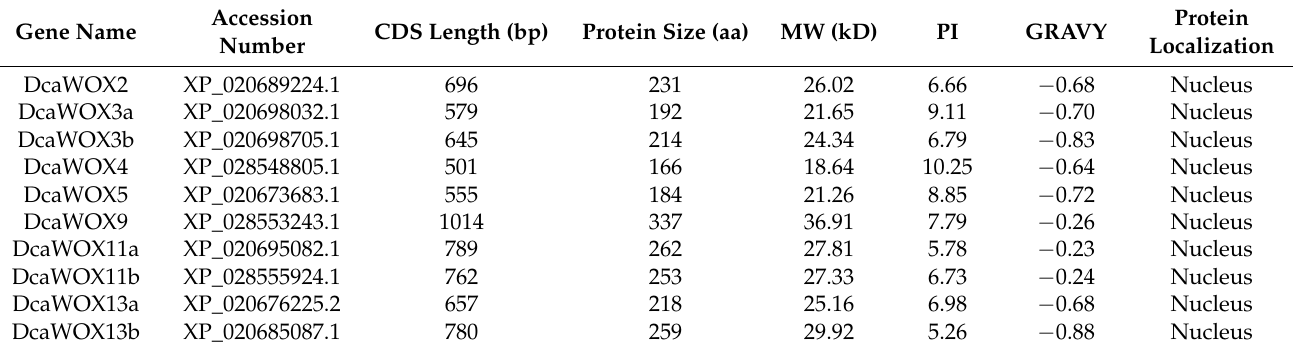
Table 1. Identification and characteristics of WOX genes in D. catenatum